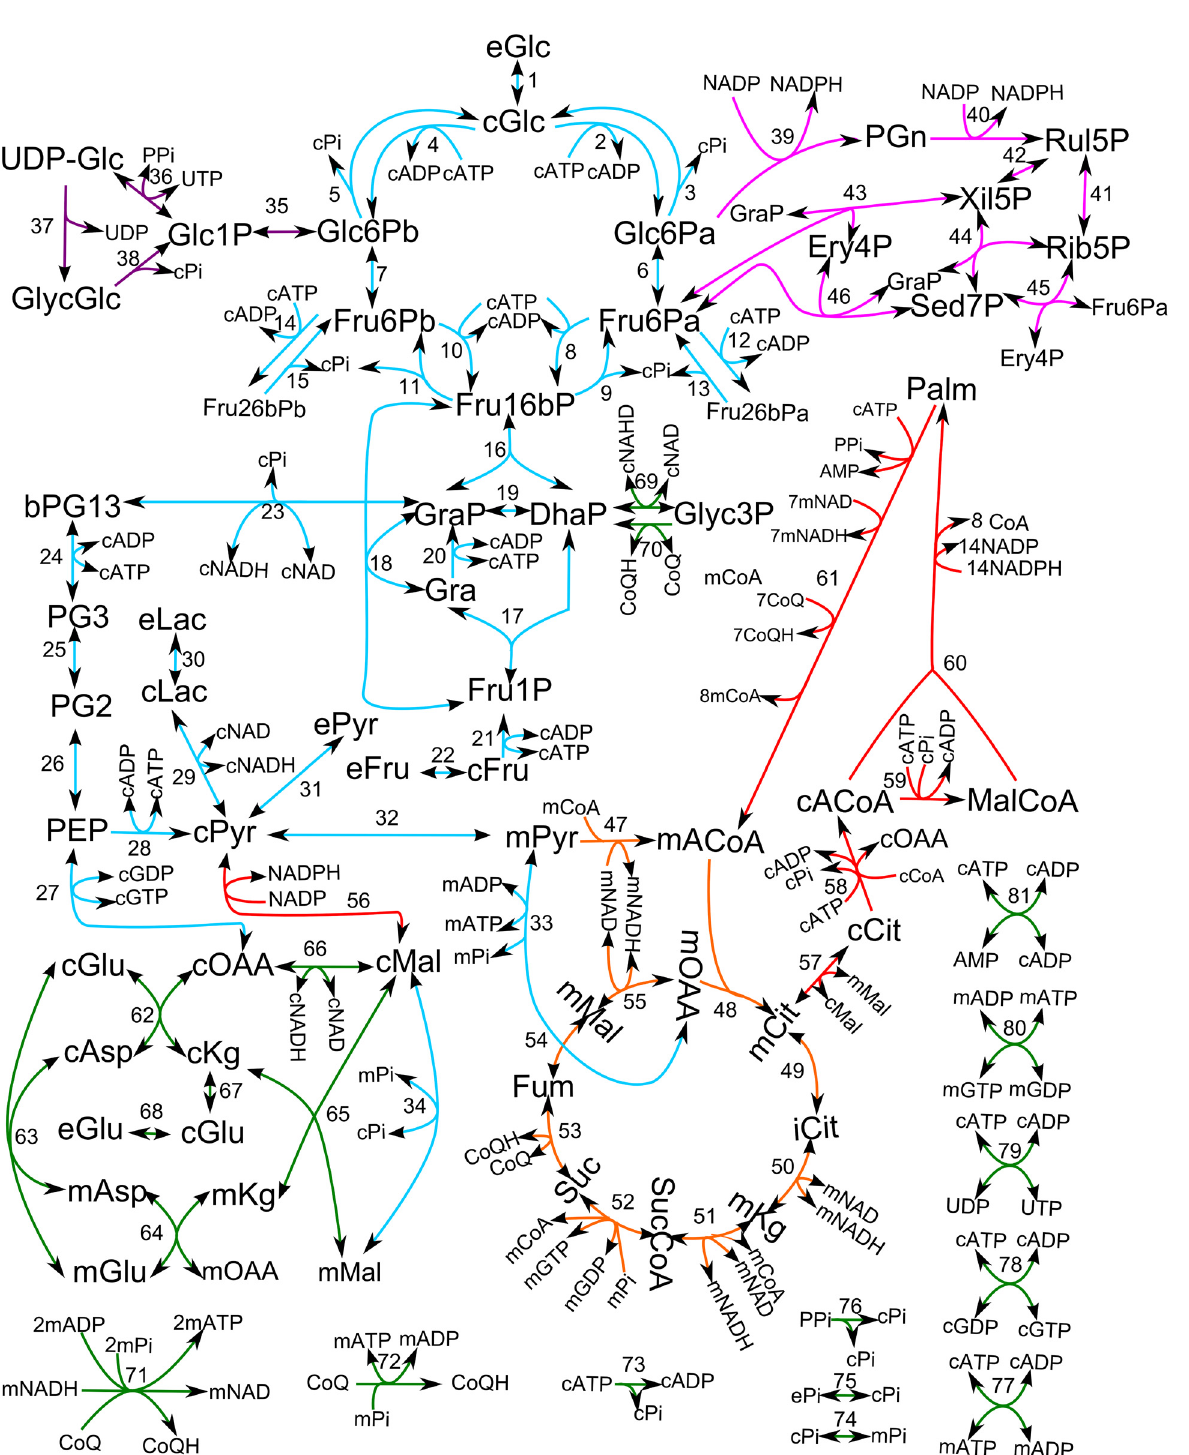
Fig 2. Schematic representation of the metabolic network used in the model. In this representation, reactions associated with the glycolytic and gluconeogenic pathways are coloured in blue, reactions associated with glycogen metabolism are coloured in purple, reactions associated with the pentose phosphate pathway are coloured in pink, reactions associated with the Krebs cycle are coloured in orange, reactions associated with fatty acid metabolism are coloured in red and other reactions associated with redox and energy metabolism are coloured in green. Specifically, the reactions id of each reaction represented are 1:glctr, 2: gka, 3 g6pasea, 4: gkb, 5: g6paseb, 6: gpia, 7: gpib, 8: pfkla1, 9: fbasea1, 10: pfklb1, 11: fbaseb1, 12: pfkla2, 13: fbasea2, 14: pfklb2, 15: fbaseb2, 16: aldo1, 17: aldo2, 18: aldo3, 19: tim, 20: trik, 21: fruhk, 22: frutr, 23: gapdh, 24: pgk, 25: pgm, 26: eno, 27: pepck, 28: pk, 29: ldh,